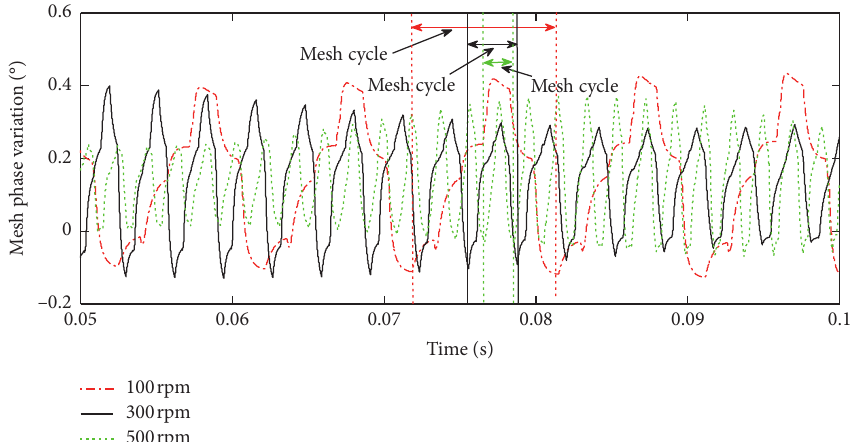
Figure 21: Meshing phase variation of s- p